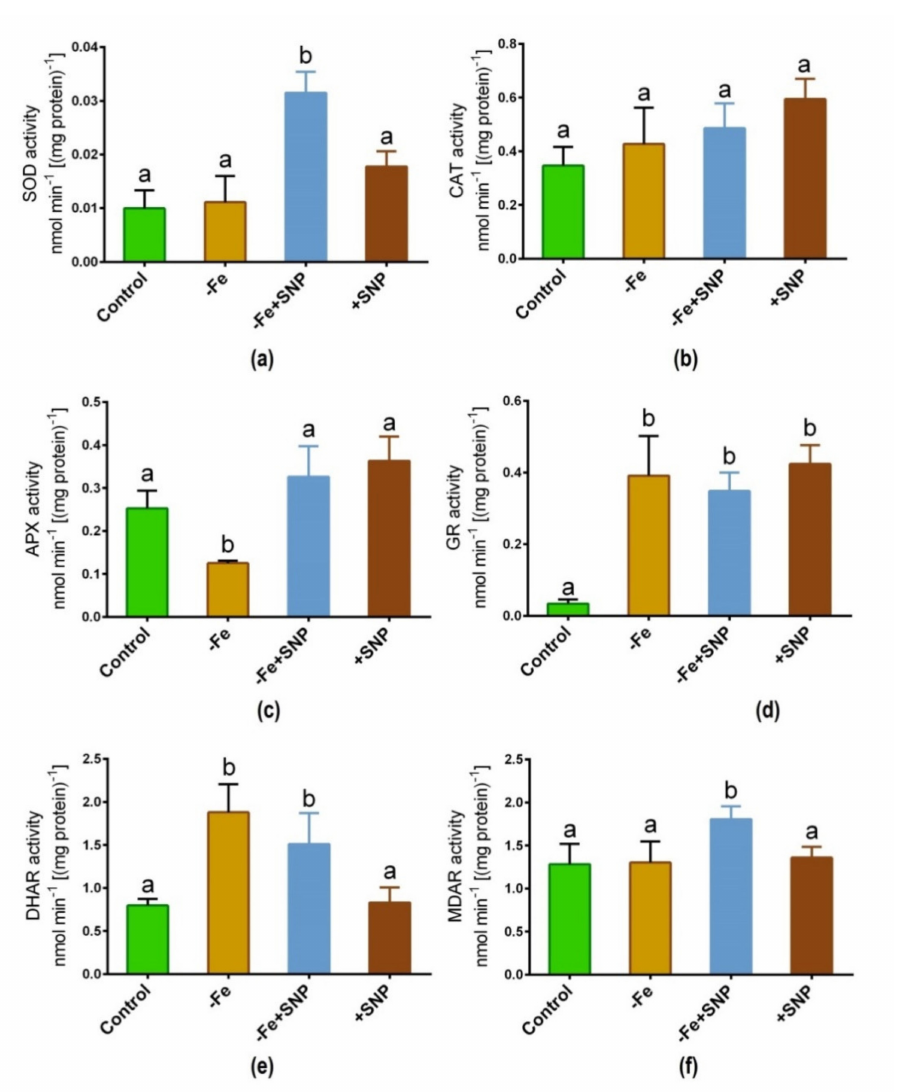
Figure 7. SOD ( a ), CAT ( b ), APX ( c ), GR ( d ), DHAR ( e ) and MDAR ( f ) enzyme activity in alfalfa cultivated with different growth conditions: control (25 µ M FeNaEDTA); − Fe (0.1 µ M FeNaEDTA); − Fe (0.1 µ M FeNaEDTA) and sodium nitroprusside (SNP, 100 µ M) as nitric oxide (NO) donor; and SNP (100 µ M). Different letters above the error bar indicate significant differences ( p < 0.05) among means ± SD of treatments ( n =